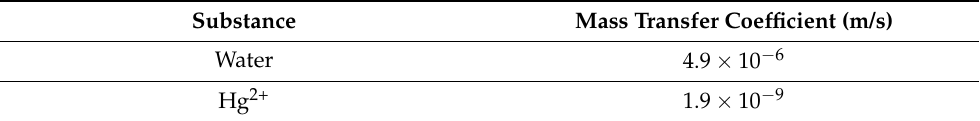
Table 1. Mass transfer coefficient for water and Hg 2+